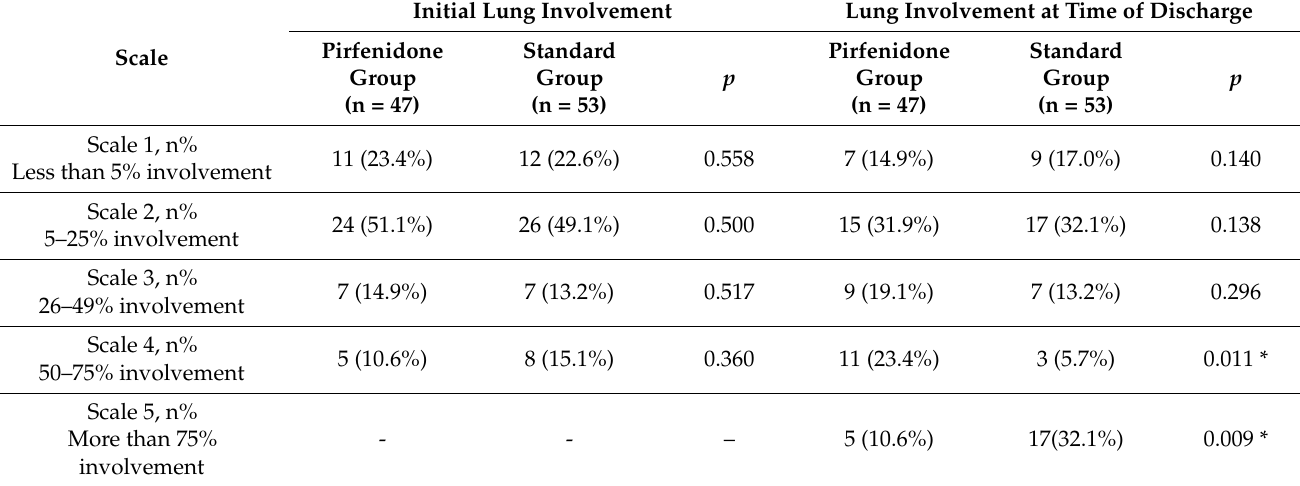
Table 4. Comparison between changes in percentage of pulmonary fibrosis involvement on CT scans from initial findings to time to discharge in both